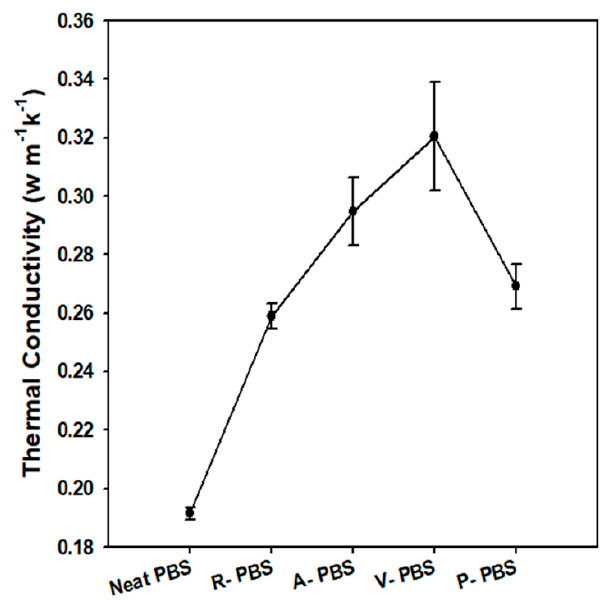
Figure 7. Thermal conductivity of neat PBS and its composites.